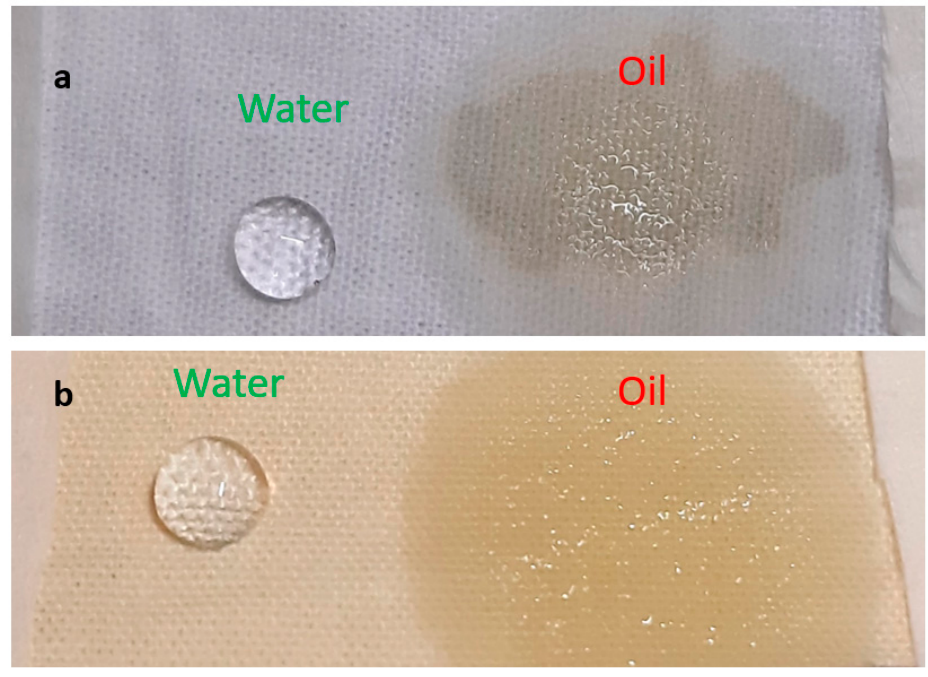
Figure 4. SEM images of ( a ) Pristine cotton, ( b ) Si-Cot_Dip, ( c ) Si-Cot_Plasma, ( d ) Cotton after oxygen plasma pre-treatment, ( e ) Si-Cot_Dip/O 2 , ( f ) Si-Cot_Plasma/O 2 (Scale bar: 10 μ m).